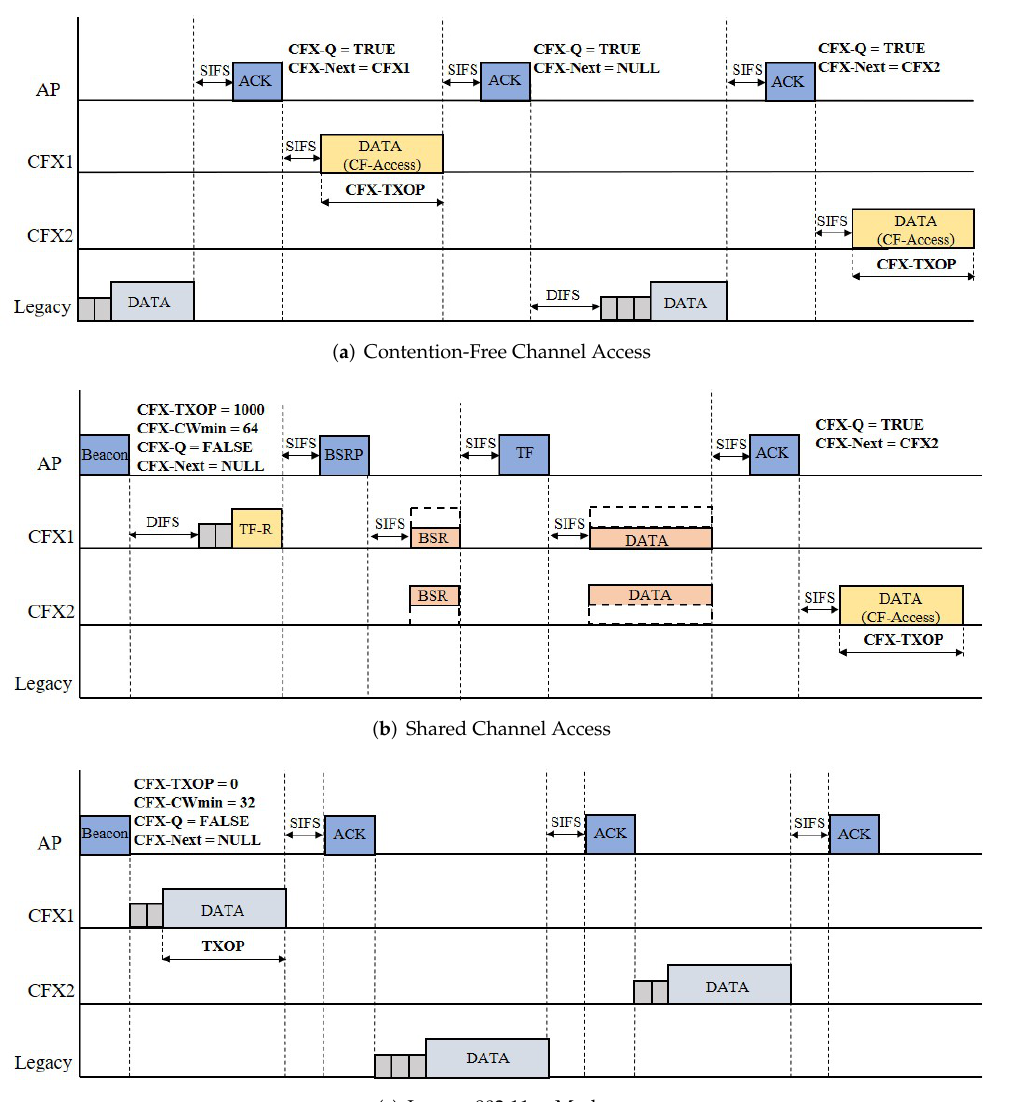
Figure 3. Comparison of the three access schemes. ( a ) In the CF channel access scheme, CFX users access the channel without contention. ( b ) An OFDMA multi-user transmission process can begin from CFX users through the shared channel access scheme, and ( c ) CFX can also operate in the legacy 802.11ax mode when insufficient benefits can be gained from CF channel